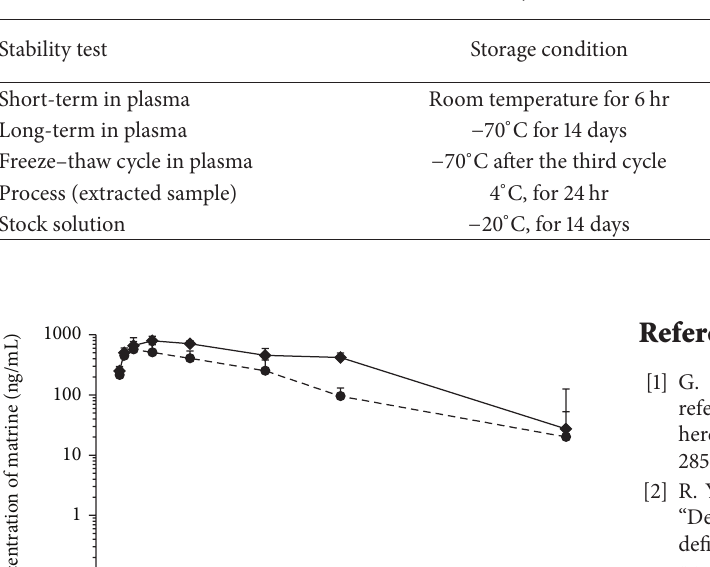
Table 2: Stability test results of matrine in rat plasma.